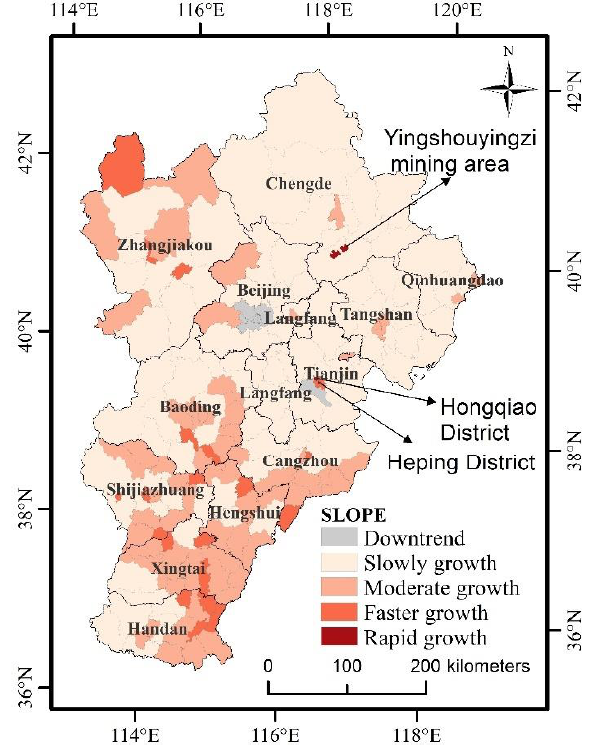
Figure 10. 2000 – 2019 Beijing – Tianjin – Hebei energy CO 2 emission trends. Figure 10. 2000–2019 Beijing–Tianjin–Hebei energy CO